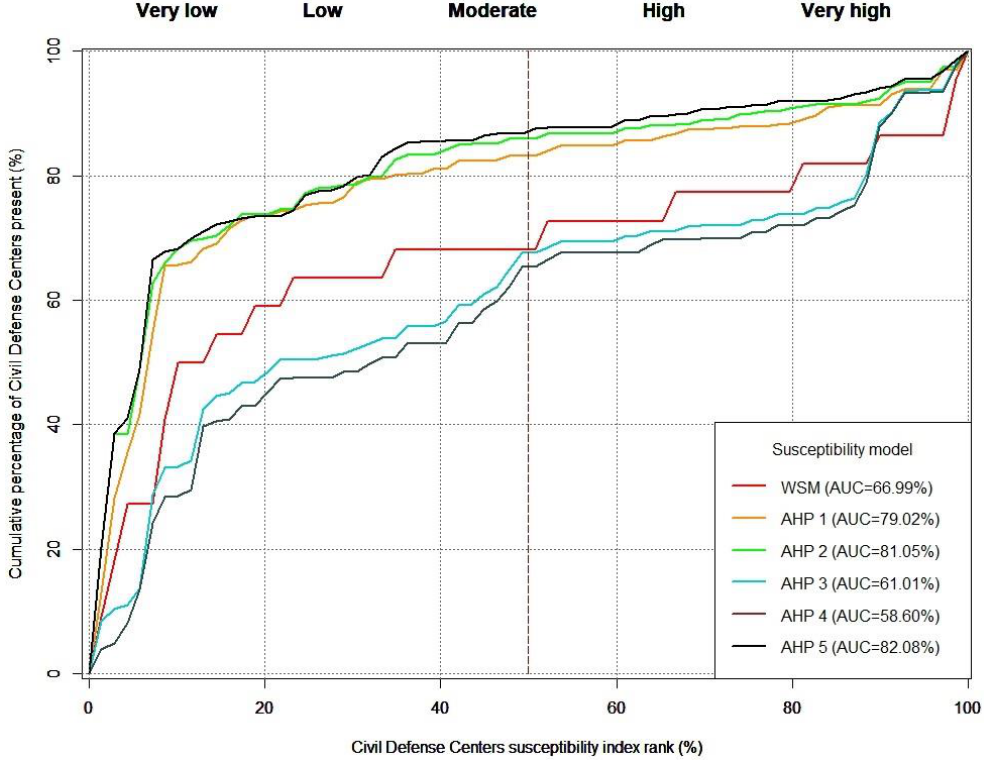
Figure 4. PRC plot evaluation of the six CDC models.